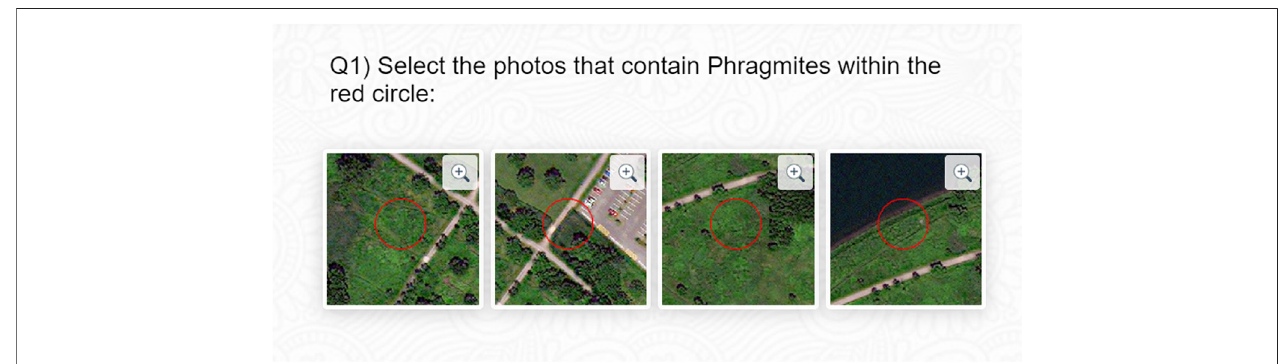
FIGURE6| Anexampleofoneofthevisualinterpretationquestionsasitappearedtotheinterpreters,whereeachsquarecontainedasubsetofthehigh-resolution Satellite DMTI Streetview imagery centered on one of the 159 validation points and the associated 15-m buffer. Interpreters selected photographs that contained Phragmites withinthebuffer.Theinterpreterscouldclickonthemagnifyingglassicontozoominformoredetail.Forthisquestion,thesecondandfourthimagesfromthe left are the correct images that contain Phragmites .